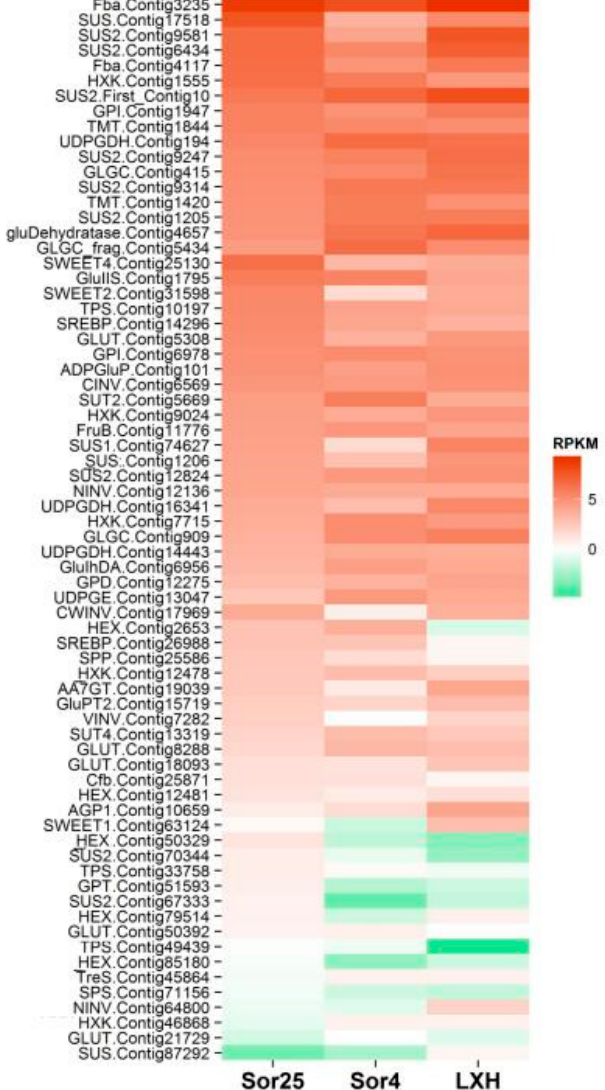
Figure 1. Heatmap of di ff erential gene expression of carbohydrates. In this figure, Sor25 means that the apical meristem of Oriental lily ‘Sorbonne’ is in the period of not vernalized yet, Sor4 means oriental lily ‘Sorbonne’ vernalization completion period in the apical meristem, and LXH means the Oriental lily ‘Sorbonne’ flower bud di ff erentiation period. The expression level represented in the heat map was log2-based. The color scale represents transcript abundance in which green to red represents a change in the expression level from low to high.